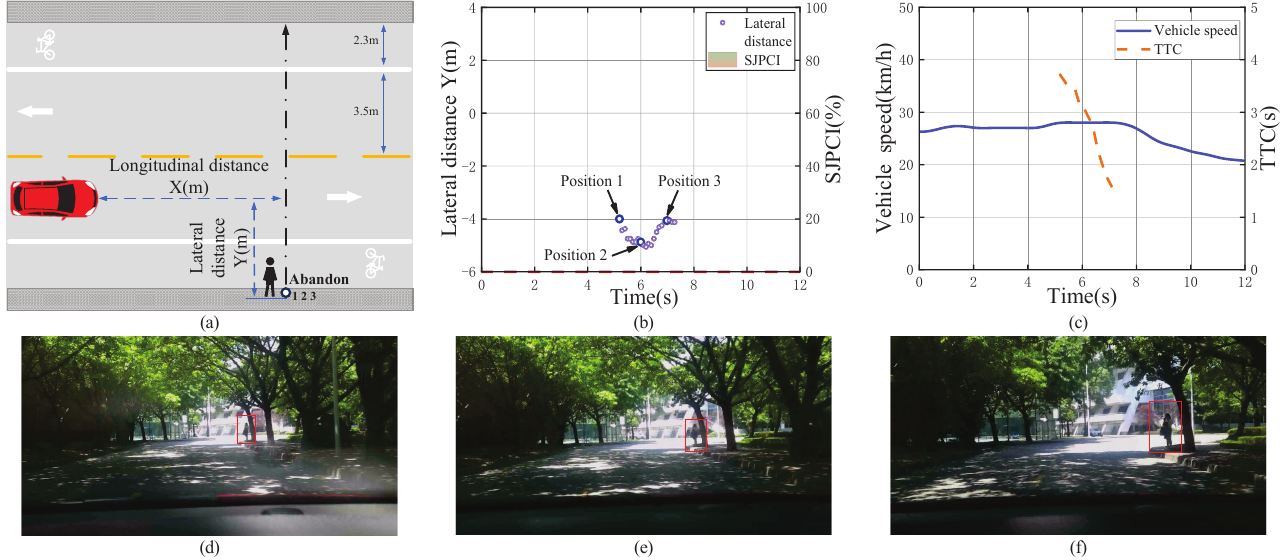
Figure 6. A non-deceleration event when encountering a pedestrian with a clear no-crossing intention and the data analysis results. ( a ) Pedestrian–vehicle interaction schematic diagram; ( b ) Lateral distance and SJPCI; ( c ) Vehicle speed and TTC; ( d ) Position 1: Pedestrians stood on the right shoulder; ( e ) Position 2: Pedestrians watched the vehicle; ( f ) Position 3: Pedestrians gave up crossing the